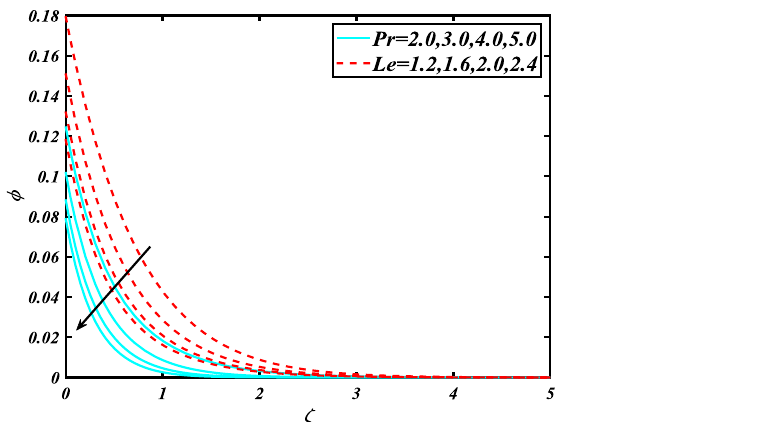
Figure 12. Significance of Pr & Le for φ .